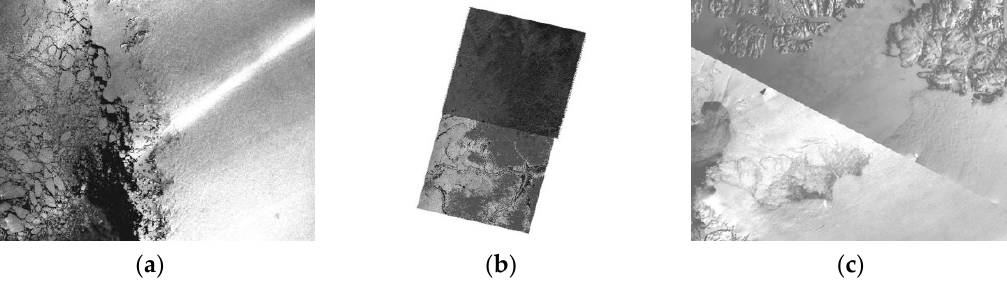
Figure 6. The image set for prove local to global radiometric balancing. ( a ) and ( c ) The image taken by argon KH-5. ( b ) The image taken by Landsat.